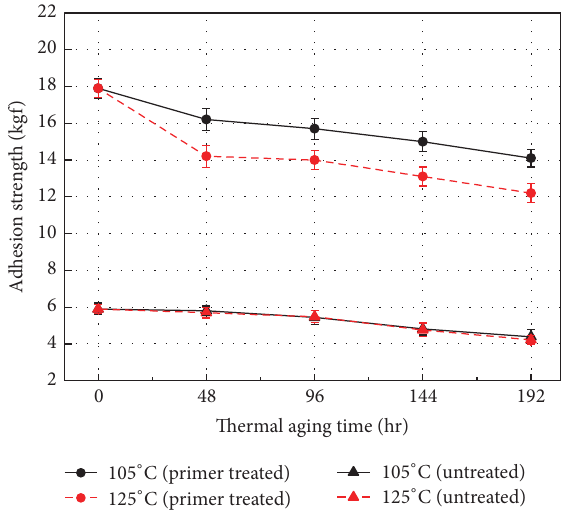
Figure 8: Adhesion properties of thermal aging at 105 and 125 ∘ C with and without primer treatment.